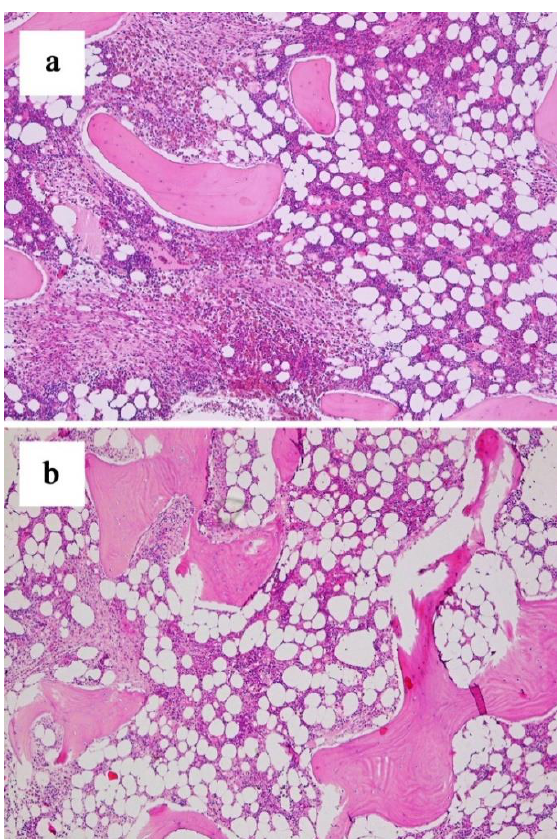
Figure 1. Clinicopathological measures of response: Serum tryptase level ( a ), bone marrow mast cell burden ( b ).